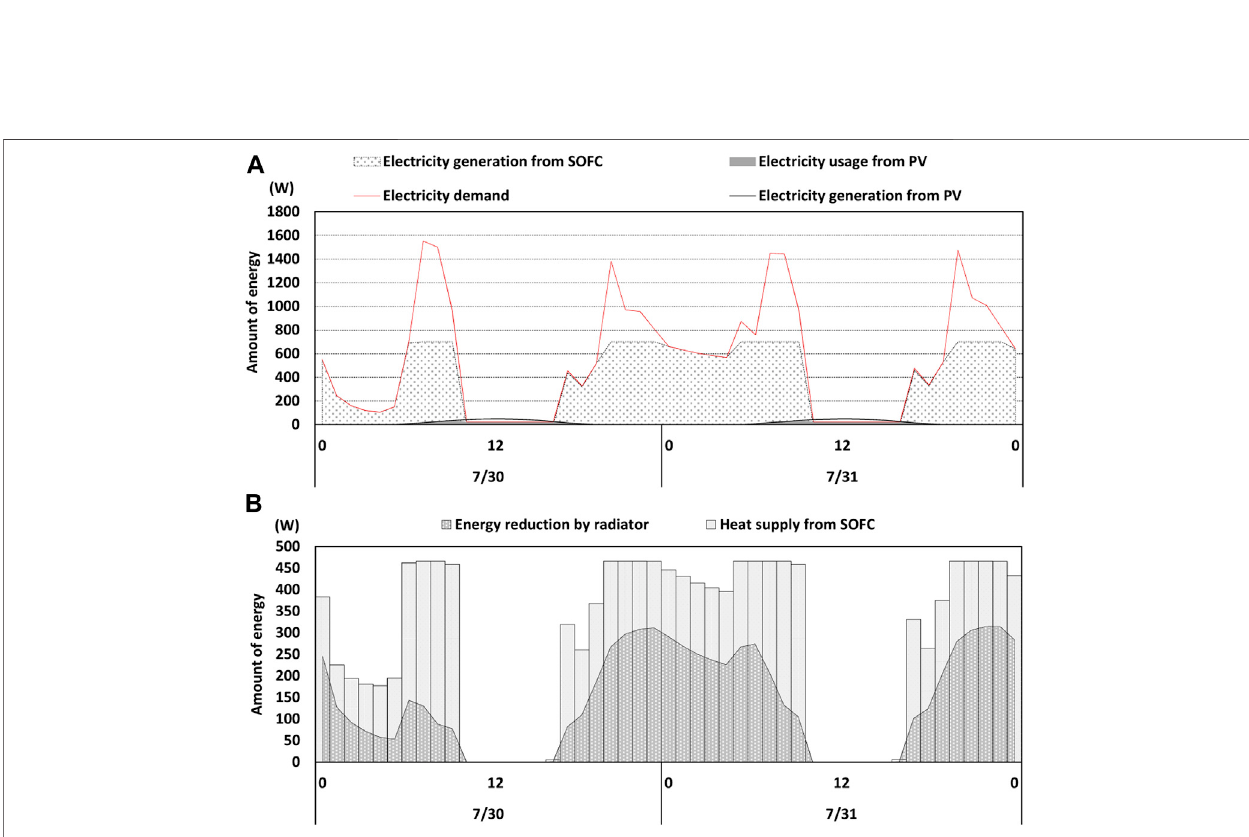
FIGURE 9 | PV/SOFC – CGS simulation for Room 3: (A) electricity supply/system and (B) heat reduction and supply.